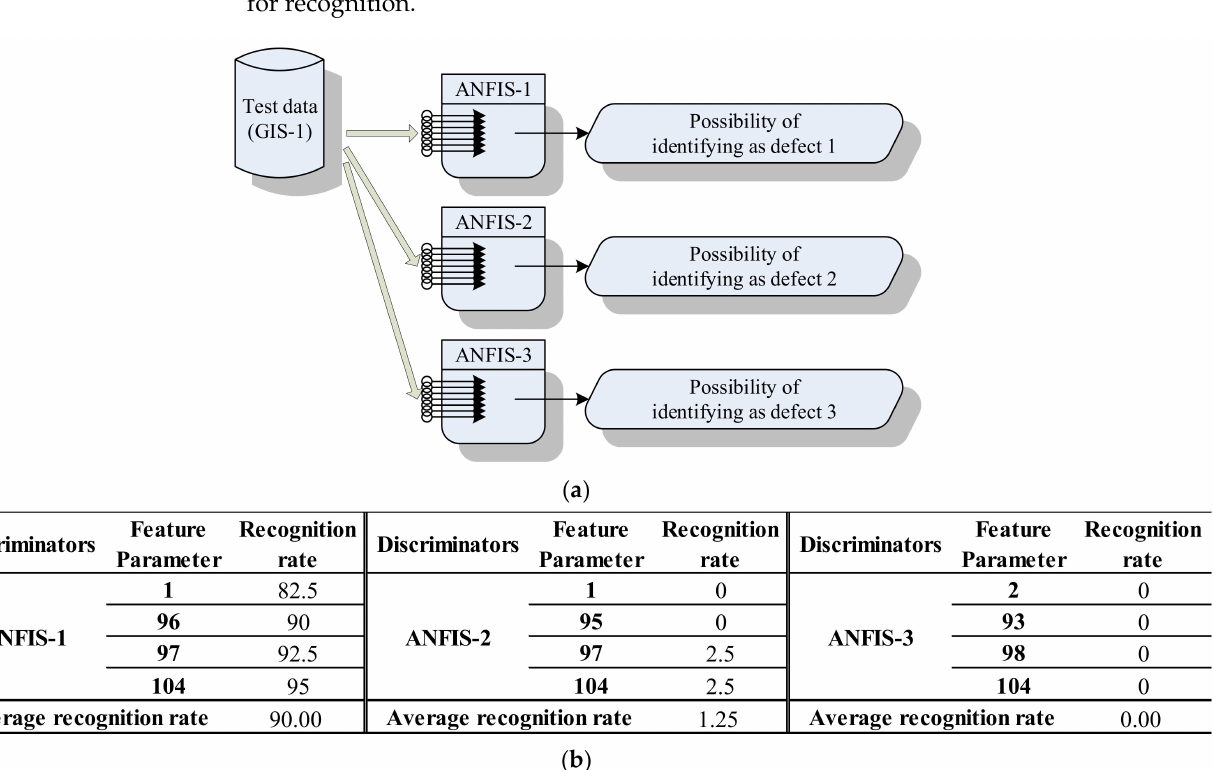
Figure 39. GIS-1 in parallel recognition system: ( a ) test architecture; ( b ) test